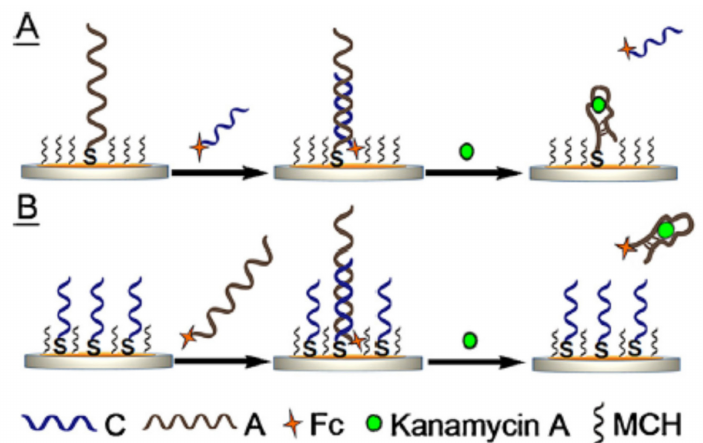
Figure 11. Schematic illustration of two approaches for the development of an electrochemical aptasensor for the detection of kanamycin A based on signaling-probe displacement. Reprinted from reference [40]. with permission from Elsevier.